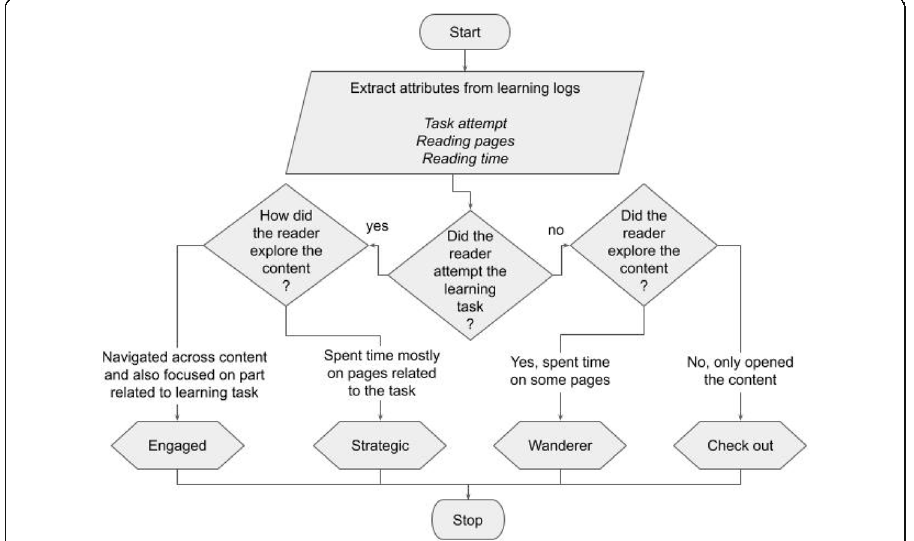
Fig. 3 Flowchart to separate learner profiles based on the learning tasks and reading